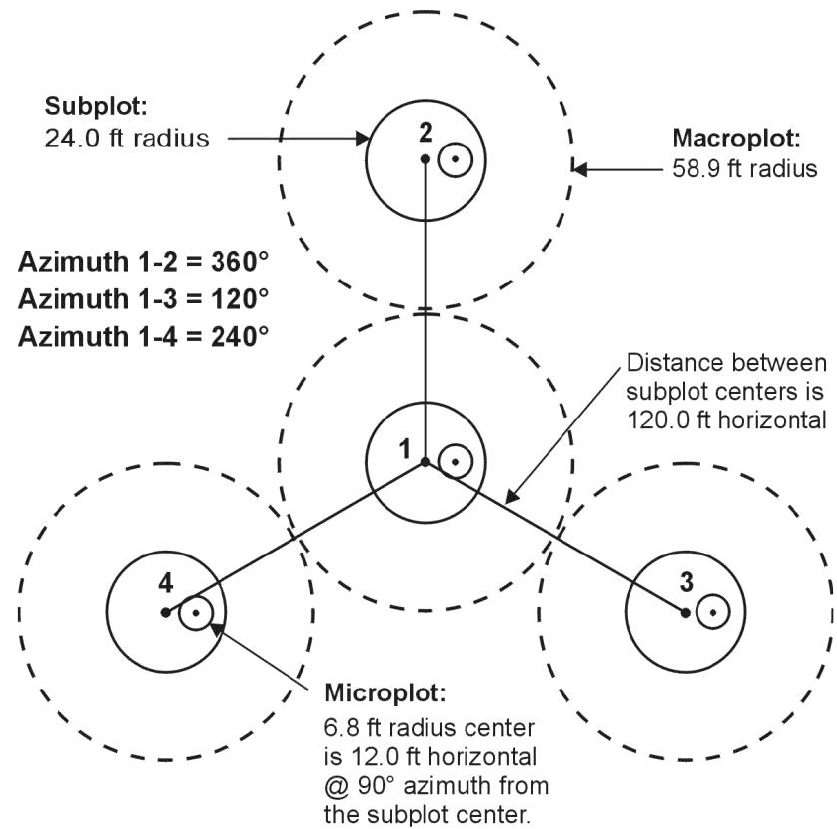
Figure 2. Schematic of FIA field plot layout [21].